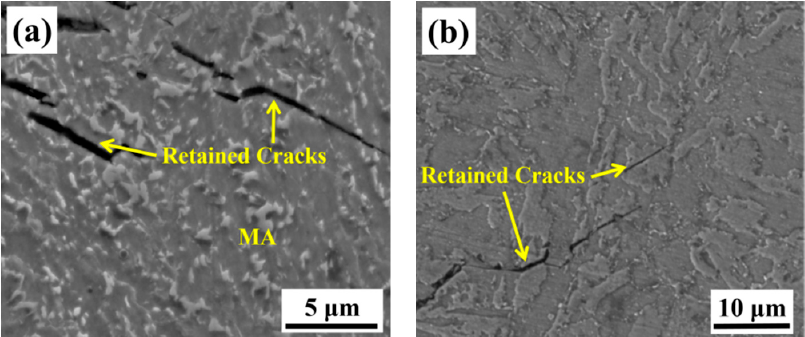
Figure 9. Retained cracks of vertical-section in Figure 3b for as-welded specimen ( a ), and for PWHT specimen ( b ).